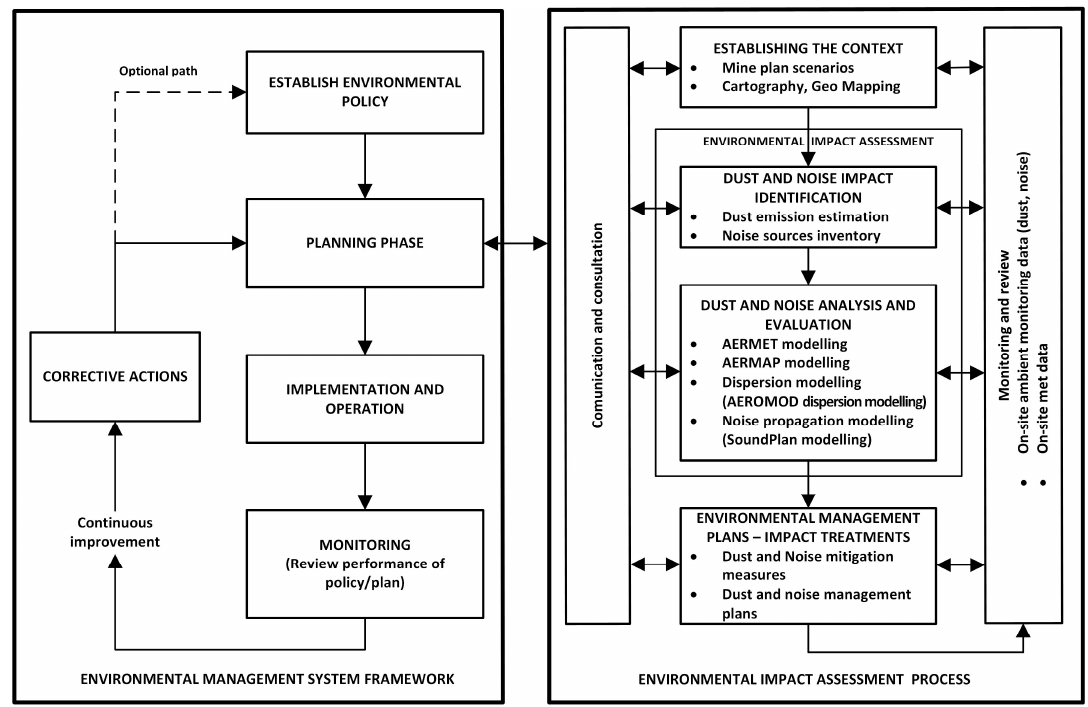
Figure 1. The conceptual framework for integrating dust and noise impact assessment and control with an environmental management system (approach modified from Ecceleston and Smythe [31] and Fitzmaurice and D’Abreton [32]).